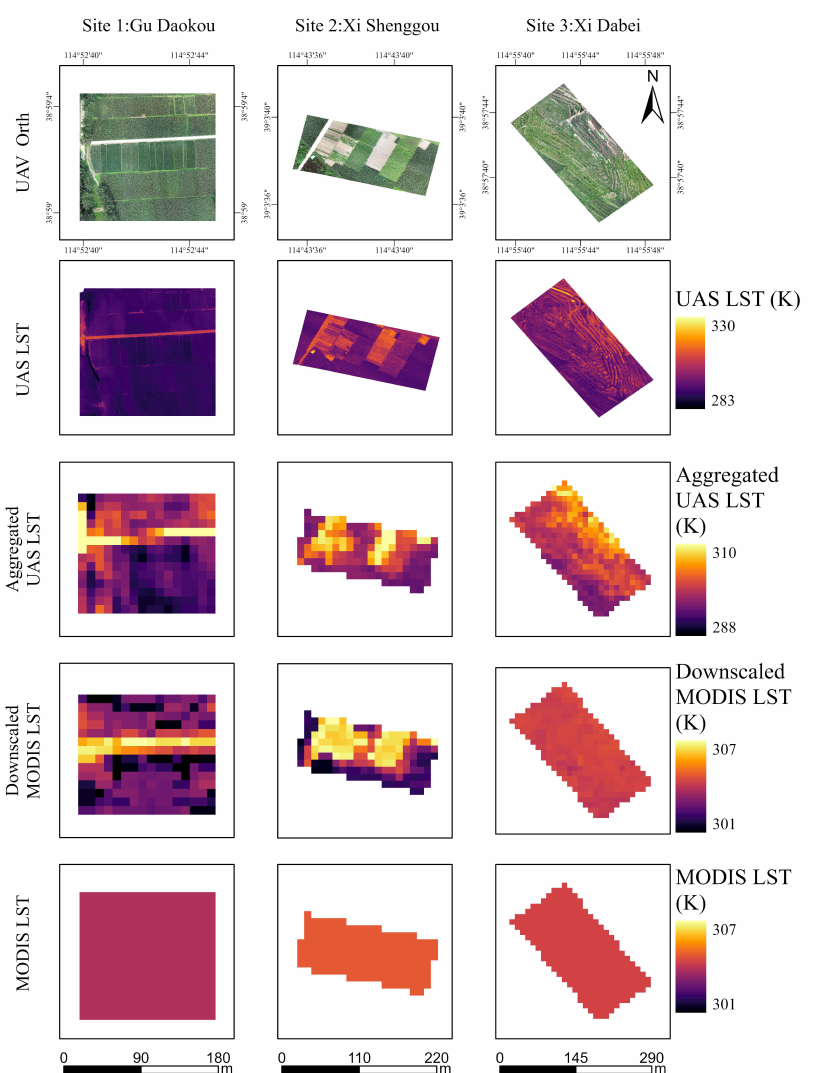
Figure 5. Comparisons among UAS orthophotos (first row), spatial distributions of UAS LST (second row, 0.1 m), UAS aggregated LST (third row, 10 m × 10 m), downscaled LST from MODIS (fourth row 10 m × 10 m), MODIS LST (last row, 1 km × 1 km) in three flight sites (Gu Daokou, Xi Shenggou, Xi Dabei at three columns